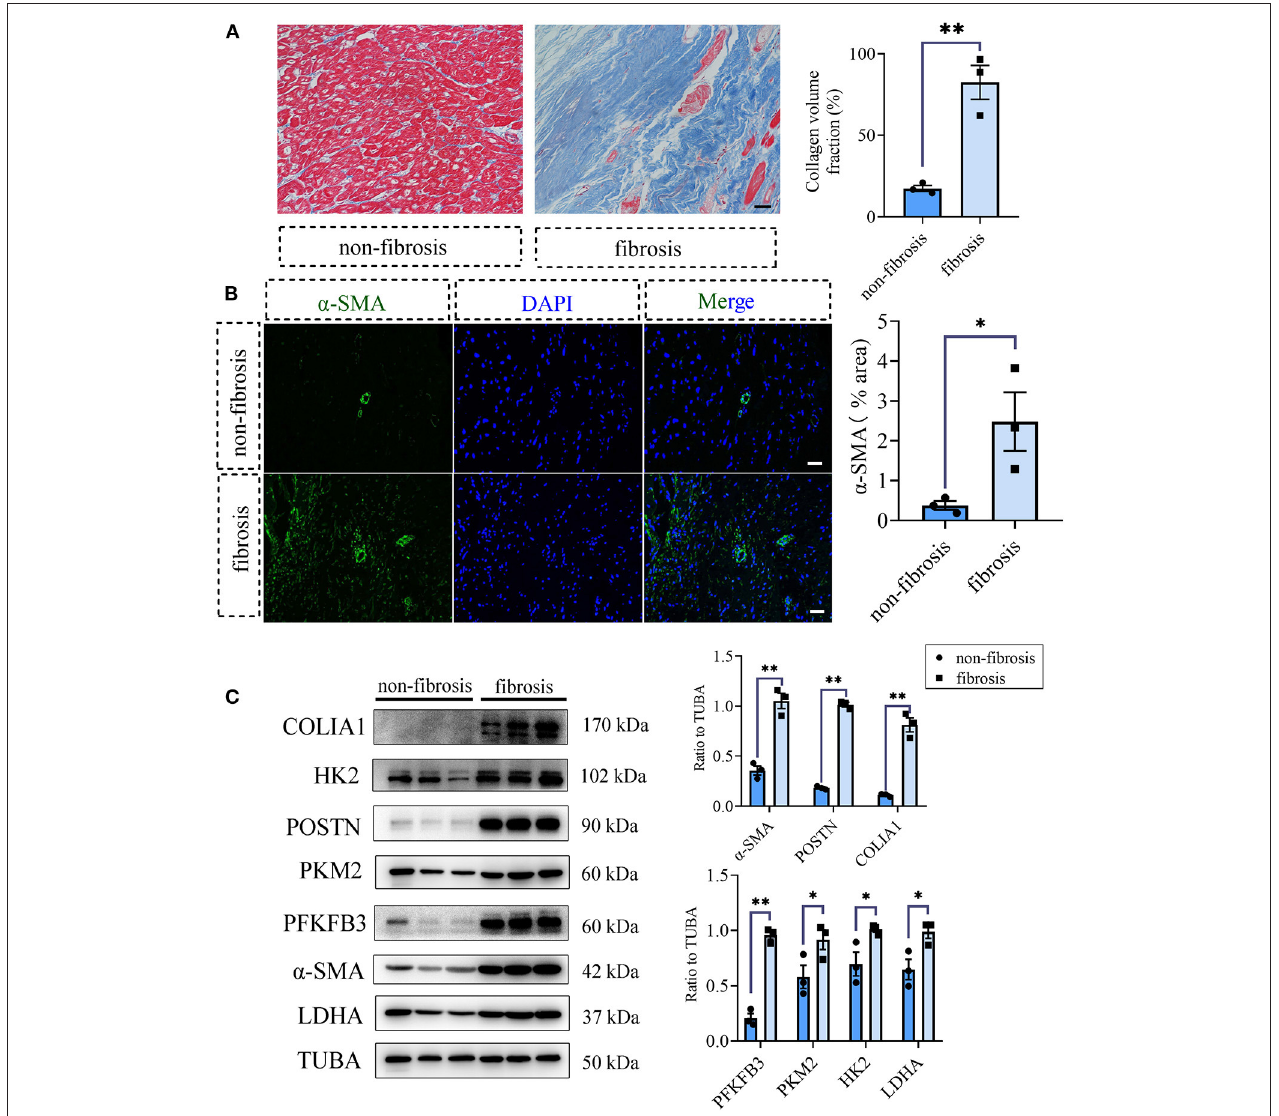
FIGURE 5 | Glycolysis increased in human fibrotic heart tissues compared with the non-fibrotic heart tissues. (A) Masson staining of the human fibrotic and non-fibrotic heart tissues. The representative image (left) and the statistical analysis (right) were shown. (B) Immunofluorescence of the human fibrotic and non-fibrotic heart tissues. The green fluorescence signal represented α -SMA, and the blue fluorescence signal represented DAPI. (C) Western blot of the expressions of glycolytic and CF activation markers of the human fibrotic and non-fibrotic heart tissues. The representative image (left) and the statistical analysis (right) were shown, respectively. N = 3; * P < 0.05; ** P < 0.01; ns, no significance. Scale bar = 100 µ